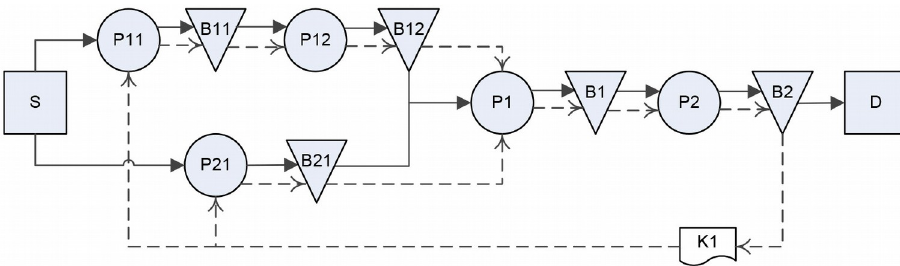
Figure 4. Conceptual mechanism of ConWIP (A2) system